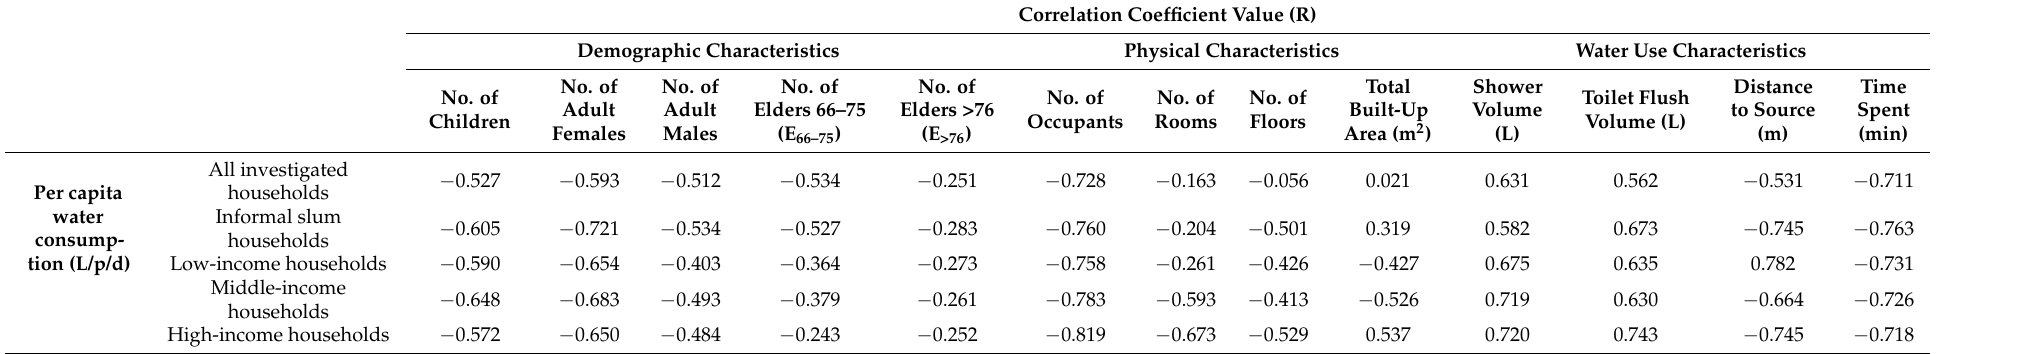
Table 5. Correlation coefficients between household characteristics and per capita water